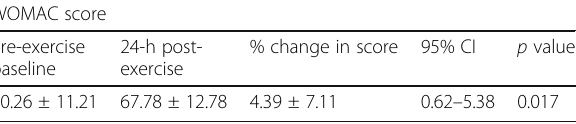
Table 4 WOMAC score before and after exercise WOMAC score Pre-exercise baseline